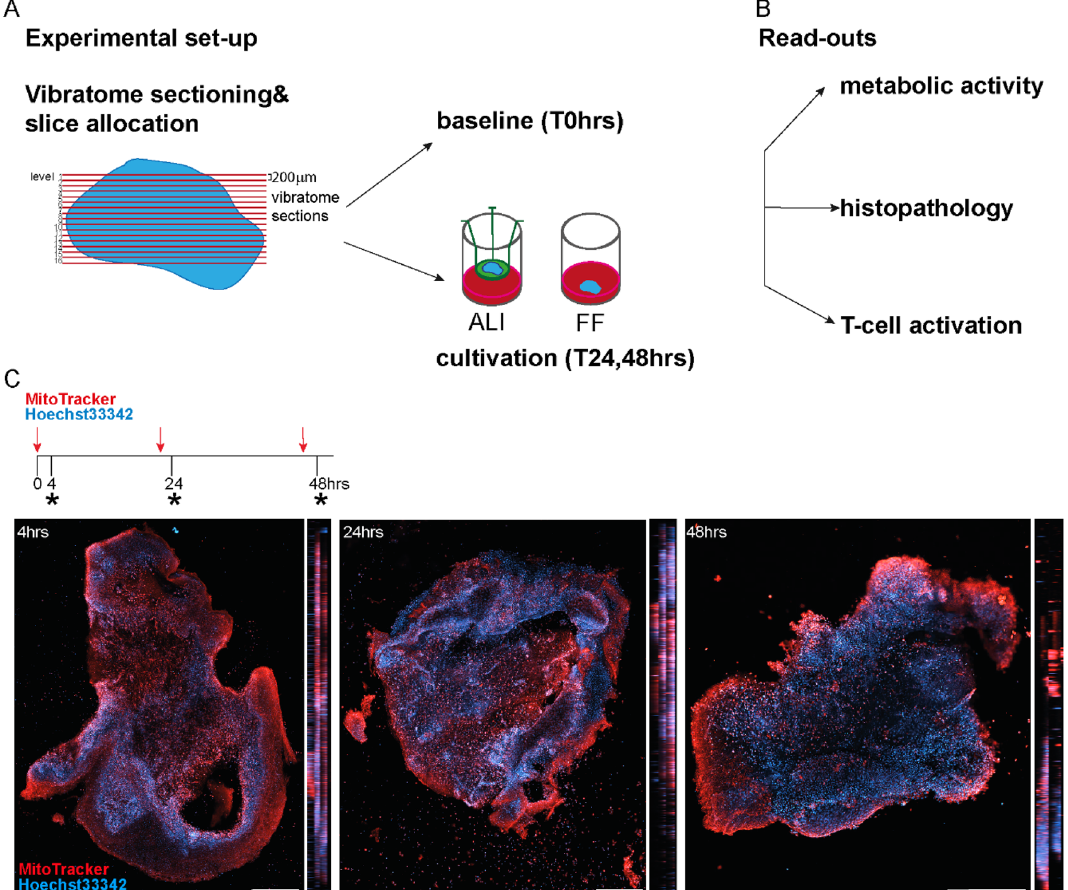
Figure 1. Experimental set-up for patient-derived HNSCC slice cultures and live assessment of metabolic activity. ( A ) Fresh HNSCC biospecimens were sectioned into 200 μm slices using a vibratome. While